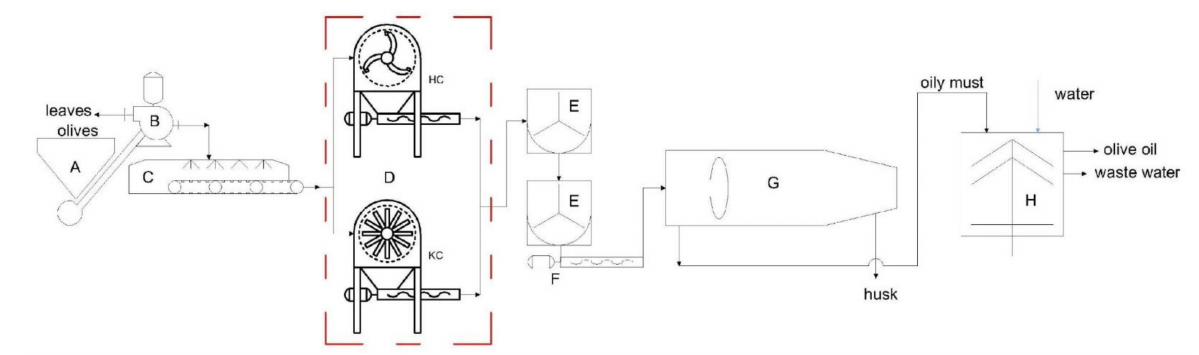
Figure 3. Layout of industrial olive oil extraction plant and process: (A) loading hopper; (B) defo- liator; (C) washing machine; (D) crusher machines; (E) malaxer machines; (F) cavity pump stators; (G) solid/liquid horizontal centrifugal decanter; (H) liquid/liquid vertical